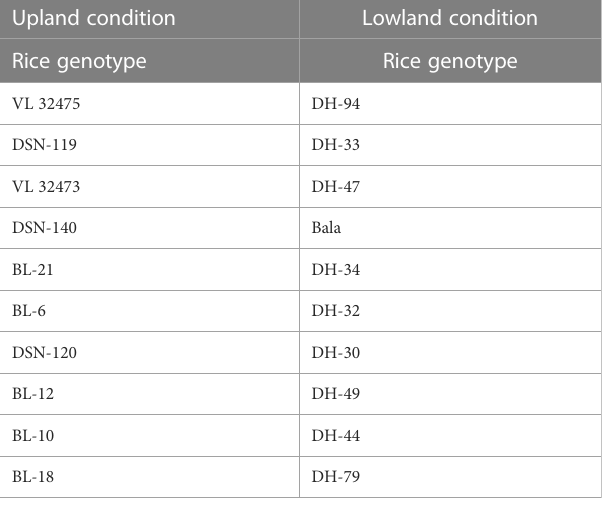
TABLE 1 Genotypes of rice grown under upland and lowland